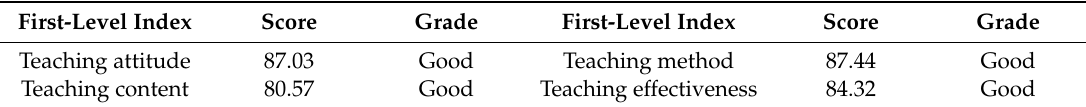
Table 3. Result of